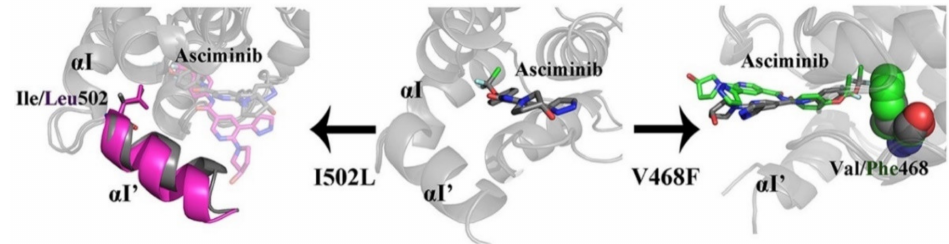
Figure 23. Effects of I502L and V468F mutations of Bcr-Abl kinase on the binding affinity of asci- minib [26].